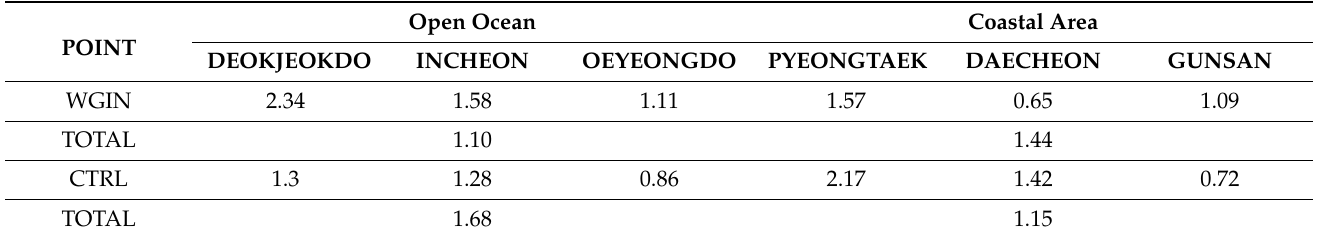
Table 7. RMSE with buoy observations of CTRL and the